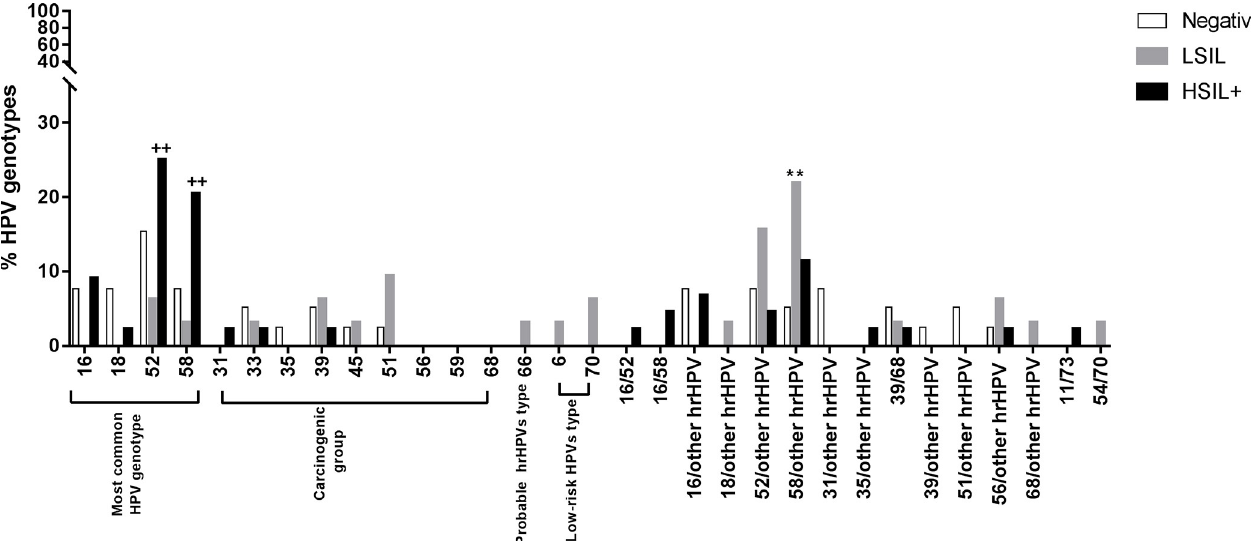
Fig 1. The prevalence of HPV genotypes in the difference histologic grades (ANOVA with turkey’s multiple comparison post hoc test: �� p < 0.01 vs. negative histology and ++ p < 0.01 vs. histologic LSIL).